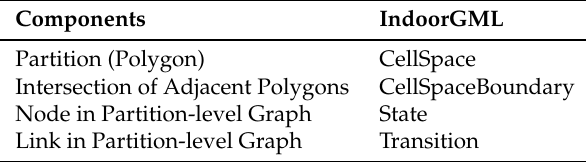
Table 3. Corresponding concepts between proposedpathfinding method and IndoorGML.